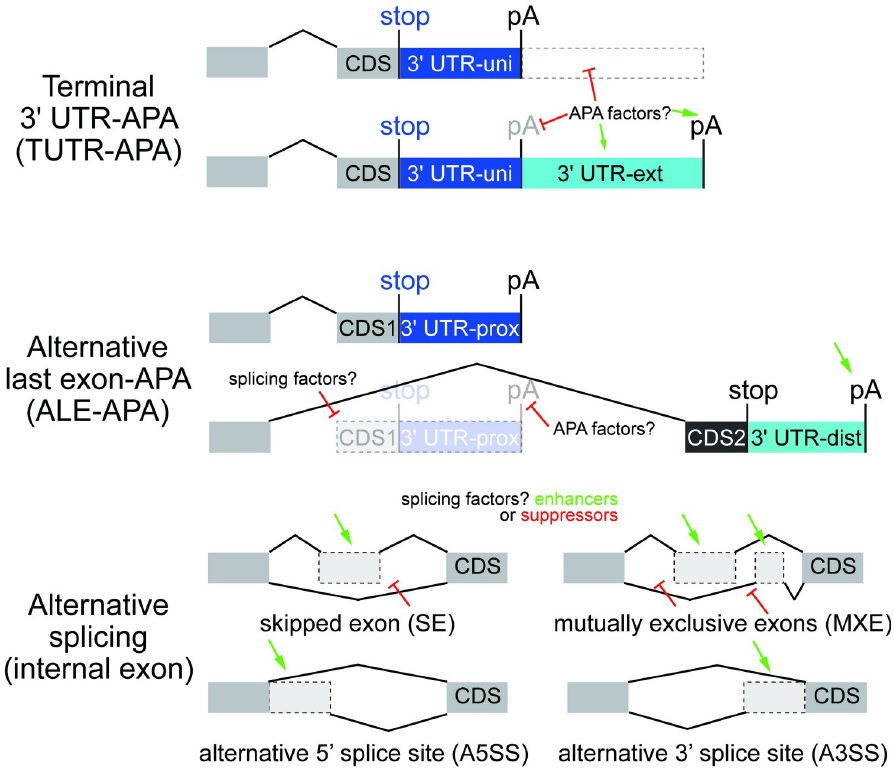
Fig 1. Summary of alternative polyadenylation and alternative splicing. Top, Alternative polyadenylation (APA) within the terminal 3’ UTR (TUTR-APA) generates 3’ UTR isoforms of variable lengths (universal/uni vs. extension/ ext). Amongst other mechanisms, APA factors might modulate recognition of proximal pA signals, or selectively modulate the stability of ext isoforms. Middle, Alternative last exon (ALE)-APA generates isoforms with variable coding last exons, along with entirely distinct 3’ UTRs (proximal/prox vs. distal/dist). In principle, these could be regulated by splicing recognition, or by pA site recognition. Bottom, Alternative splicing of internal exons can be classified into several groups, and can be influenced by splicing enhancer or suppressors that bind in exonic or intronic regions. Not shown, alternative 5’ exons generated by distinct transcriptional start sites. This study will focus on exon skipping and the mechanistic relationship of TUTR-APA and